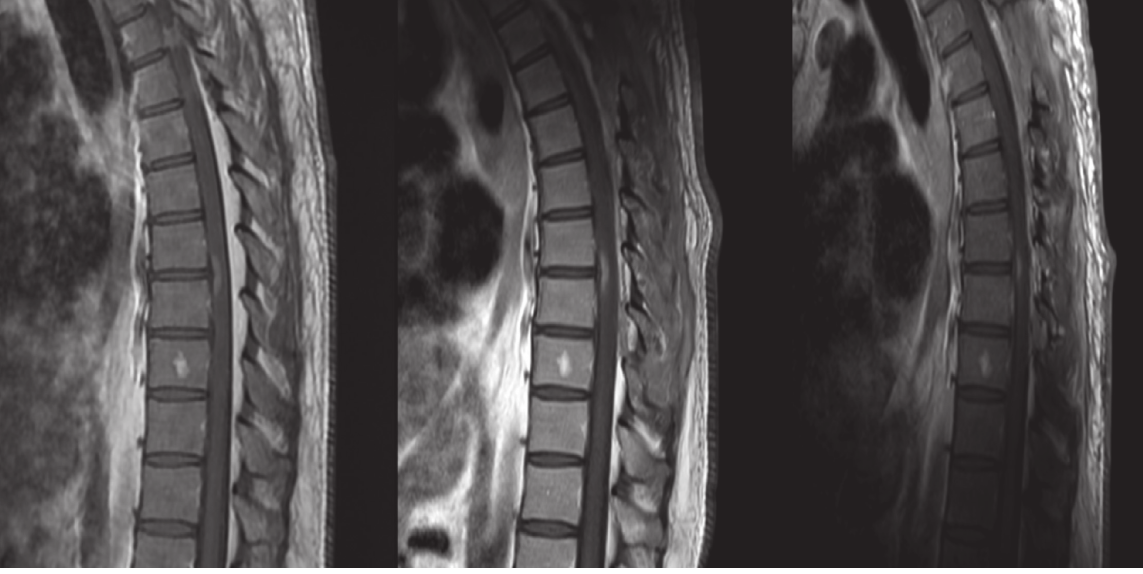
Figure 7: Sagittal T1 MRI with gadolinium showing the decrease in extent of enhancing lesion from initial MRI, after surgery, and after treatment.